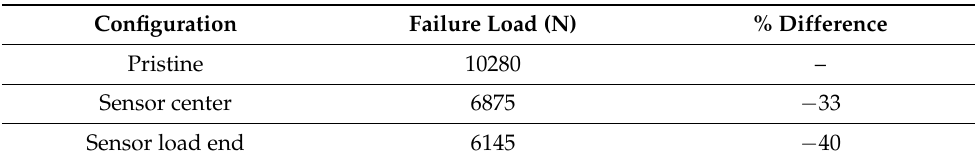
Table 4. Average tensile failure load.